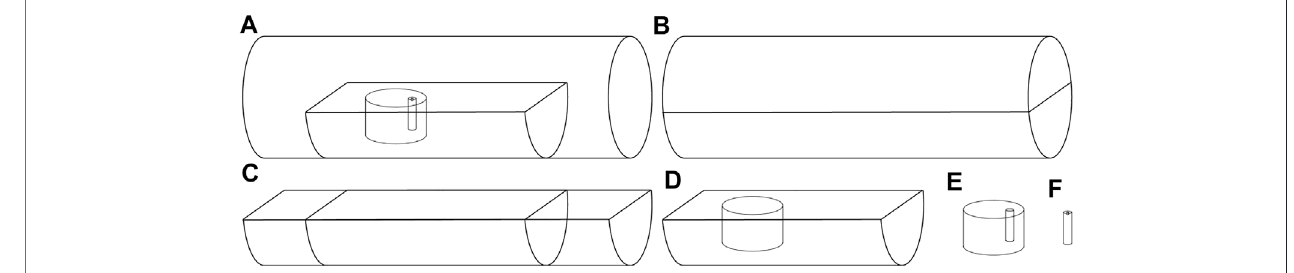
FIGURE 1 | Schematic drawings ofthe sampling and analysis methodology of this study. (A) Overview of all a sample types in their relation to the original drill core. (B) Adrillcoreiscutinhalf.OnehalfcoreisanalyzedbywholerockXRFandtheotherhalfislogged. (C) Theloggedhalfcoreissubsampled.Inthisstudy,anXCTscanat 45 μ m voxel size was performed on one subsampled half core (2). (D) A rock chip is cut from the half core sample, polished, and epoxy-mounted. In this study, XCT scans at 30 μ m voxel size were performed on four rock chips and 30 μ m pixel size AM scans on their polished surface (1 – 4). (E) A mini core is drilled from the rock chip sample. In this study, XCT scans at 4 μ m voxel size were performed on two mini cores and 1 μ m pixel size AM scans on their polished surface prior to drilling (2, 3). (F) AcylindricalvolumeofinterestwithintheminicoreisselectedforXCTanalysis.Inthisstudy,XCTscansat1 μ mvoxelsizewereperformedinvolumesofinterestintwo mini cores (2, 3).